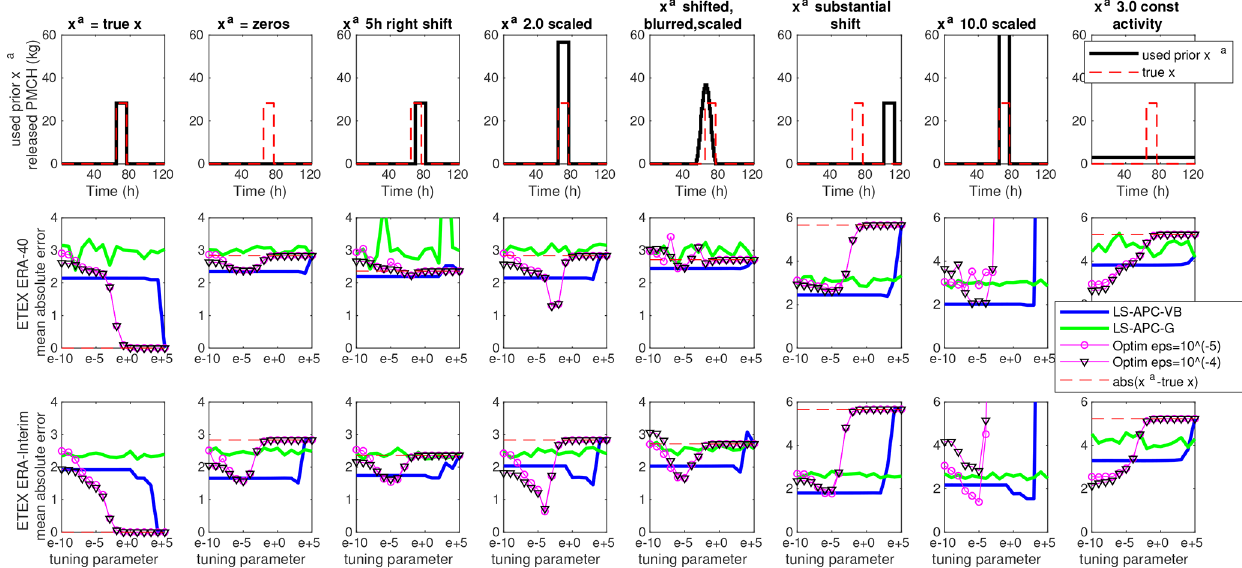
Figure 1. The uppermost row of panels shows eight different prior source terms x a (black lines) used for the ETEX source term estimation. The true ETEX source term is repeated in every panel (red dashed line). The middle and the lowermost rows display the mean absolute error between estimated and true source terms for the ETEX ERA-40 and ETEX ERA-Interim datasets, respectively.